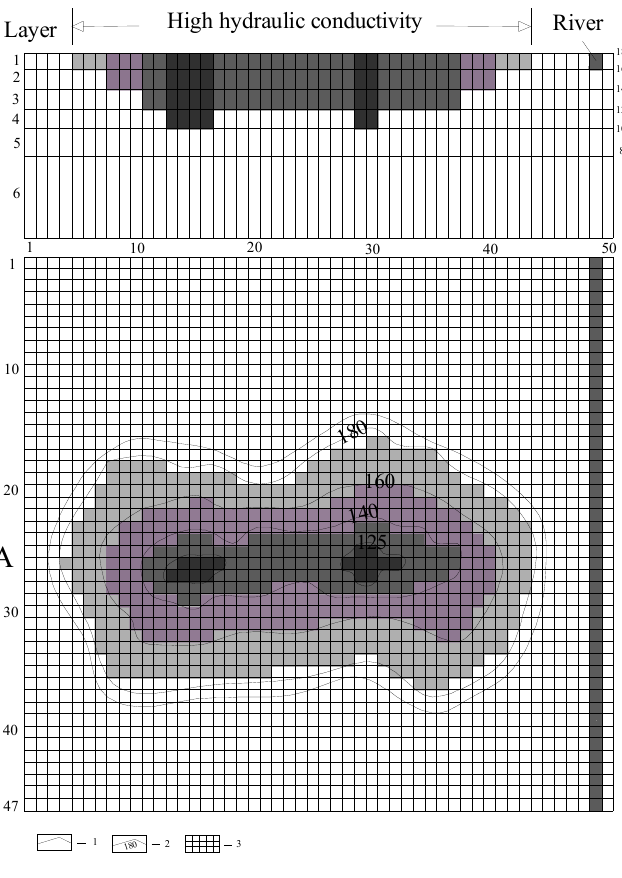
Figure 3. Simulation of a post-mining void using “high conductivity cell” method. Explanation: 1 —mine boundary area, 2 —surface contour interval, 3 —mesh discretization [33].